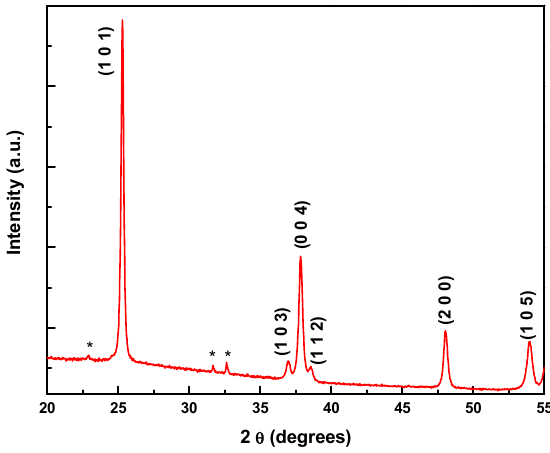
Figure 3. X-ray diffractogram of the TiO 2 after annealed at 480 °C.